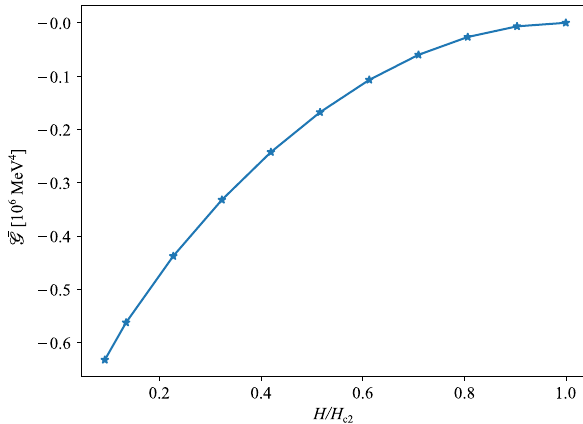
Fig. 1 Average Gibbs energy density of the Abrikosov vortex lattice, relative to the vacuum state, as a function of H at μ I = 147